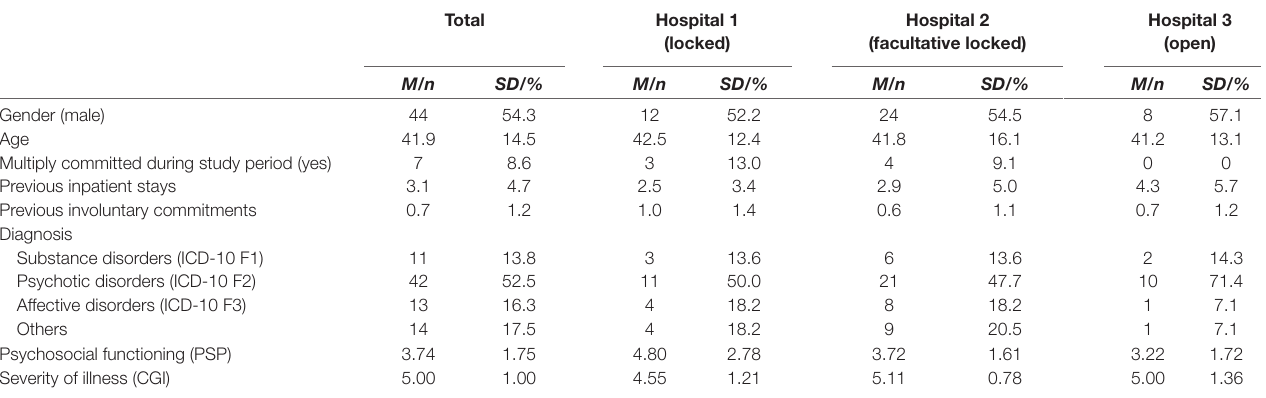
TABLE 2 | Sample characteristics in total and per